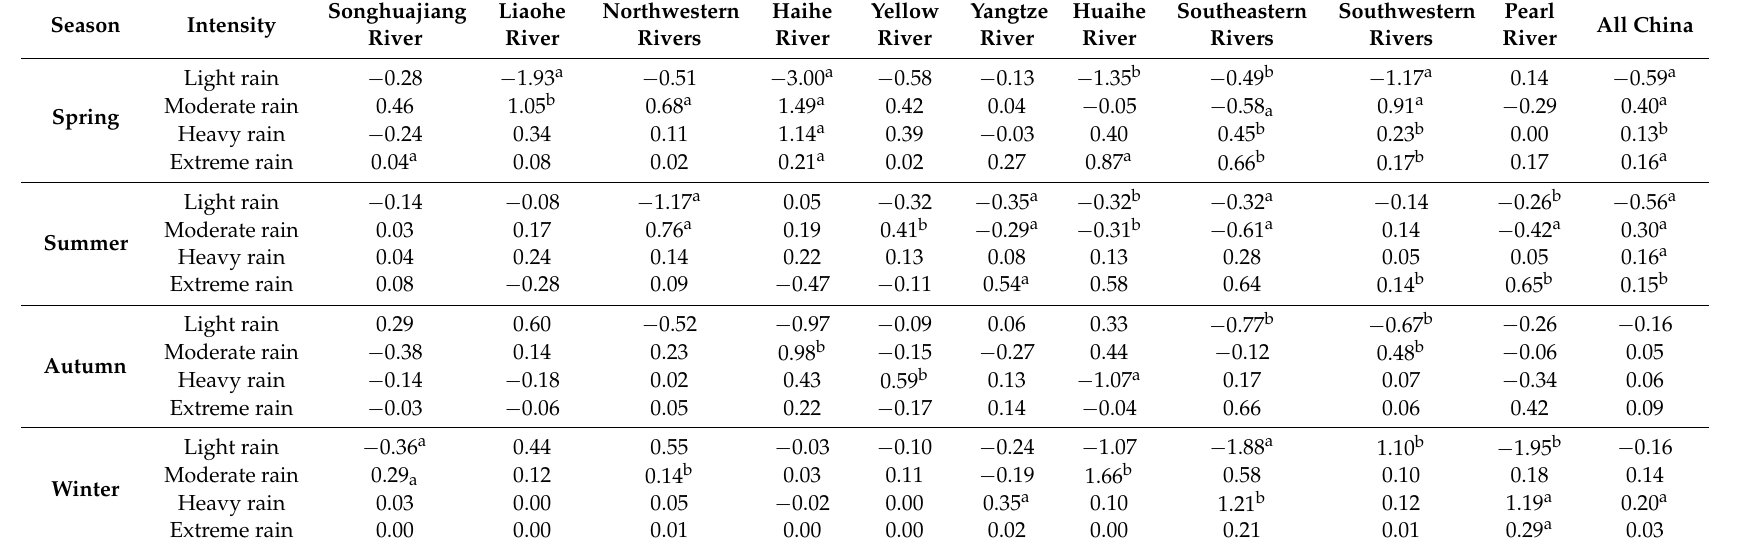
Table 4. Seasonal trends in precipitation intensity proportions over China’s large river basins during 1960–2013 (%/10yr). Songhuajiang Season Intensity